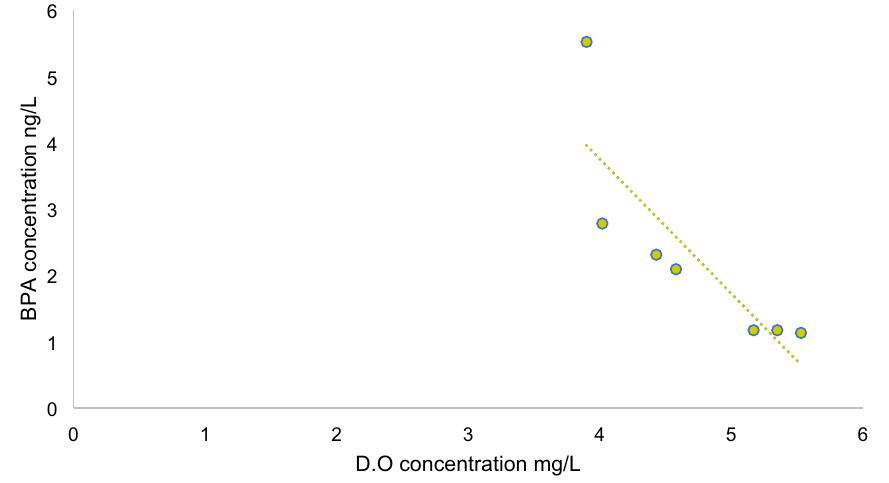
Figure 11. Correlations between dissolved oxygen concentration and BPA in Bentong